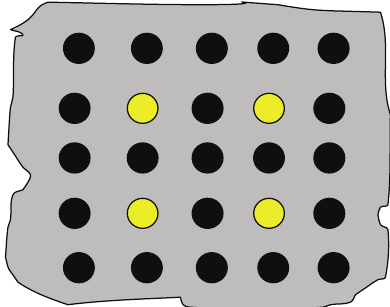
Figure 5: Concept of square unit cell for aligned pattern of composite with one in set of four fibres of unit cell totally debonded.